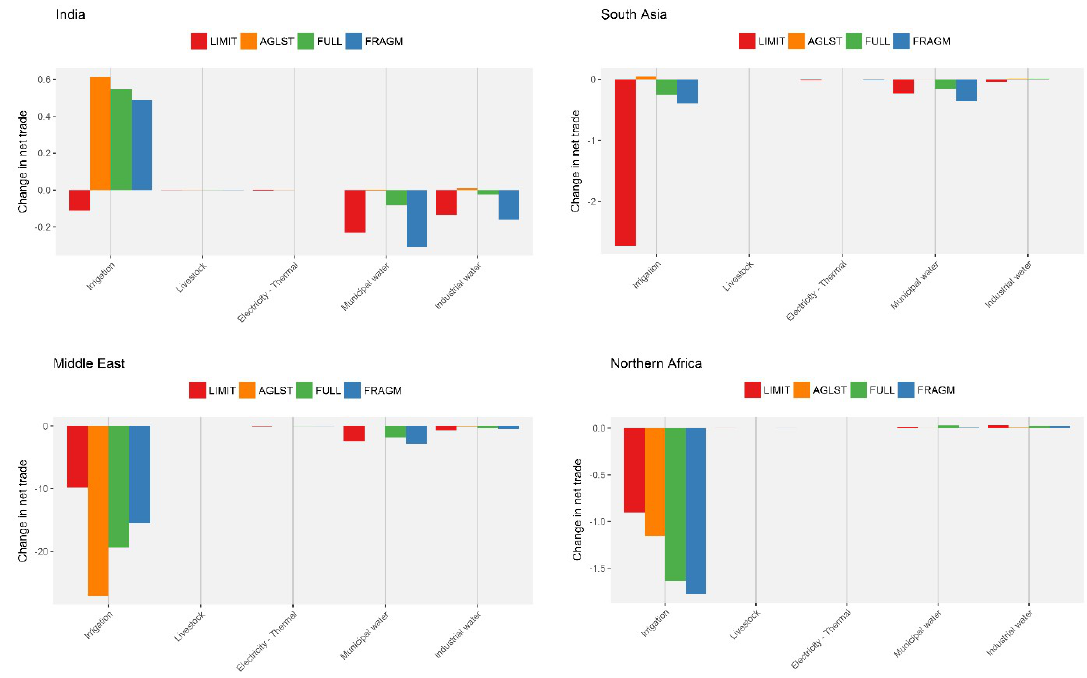
Figure 8. Changes in net trade of virtual water by water category (in km 3 ).